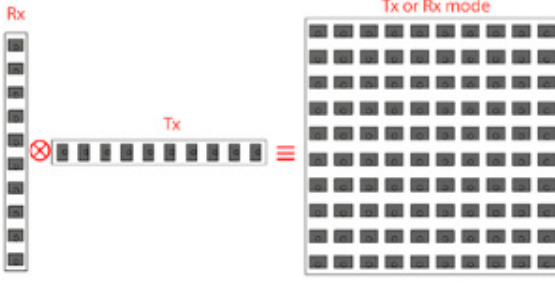
Figure 1. Virtual antenna array concept.